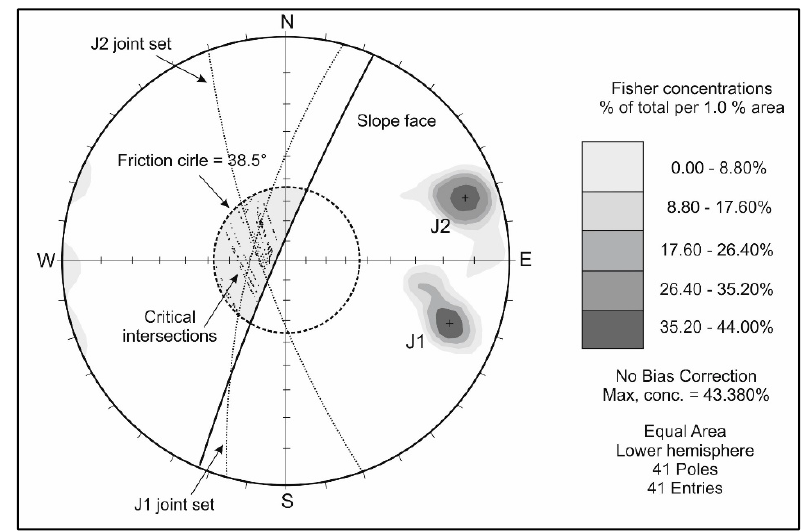
Figure 9. Kinematic stability analysis, performed by means of the Markland’s test, for potential wedges defined by the intersections between the great circles of joints belonging to the J1 and J2 joint sets.